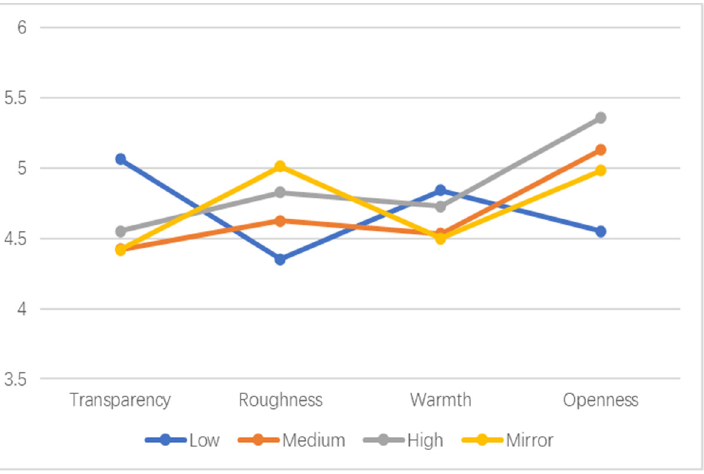
Figure 4. Mean value of finish classification.